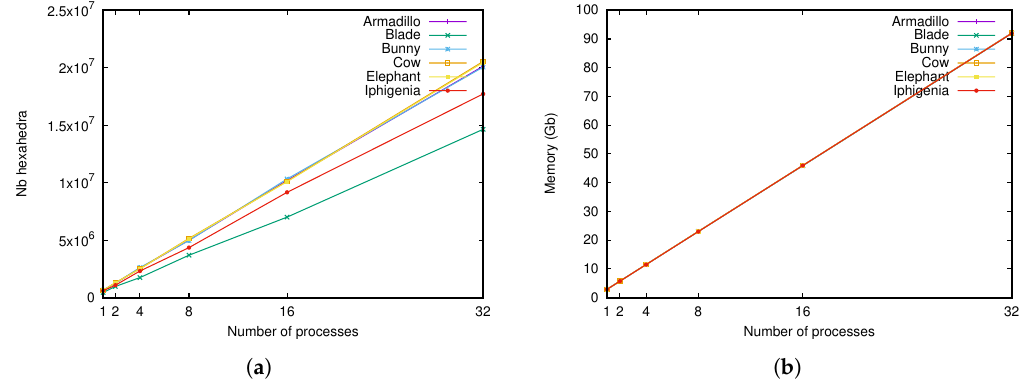
Figure 12. Comparison of maximal number of hexahedra and memory space occupied when using a 3-dmap for different number of processes. ( a ) Final number of hexahedra. ( b ) Maximal memory space occupied (in gigabytes). The six curves are superposed, because all runs occupy the same maximum memory